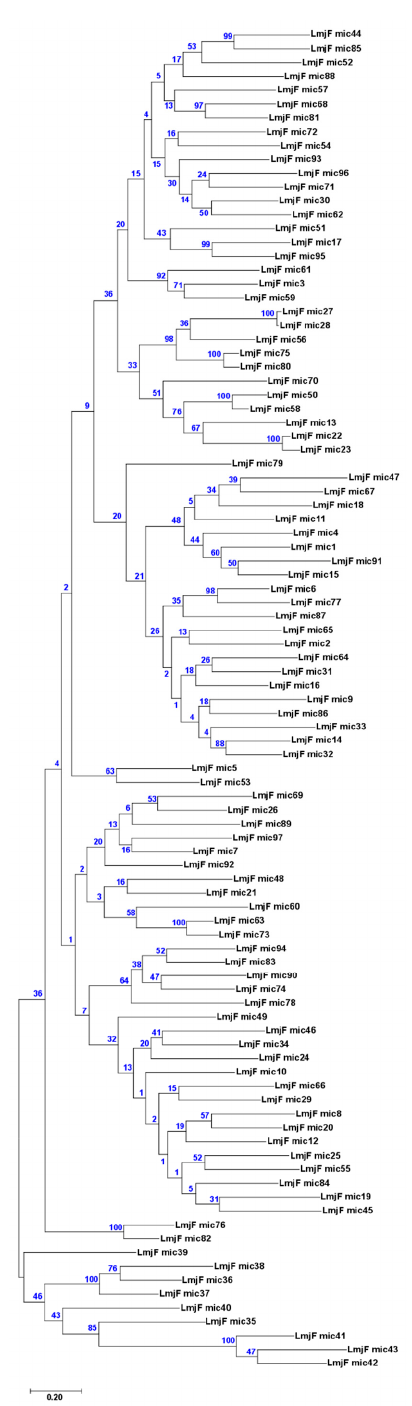
Figure 5. Sequence divergence among the 97 L. major assembled minicircles (circular) inferred by evolutionary analysis. The analysis was carried using the maximum likelihood method and Tamura-Nei model [39]. The tree with the highest log likelihood (–67786.96) is shown. The percentage of trees in which the associated taxa clustered together is shown next to the branches (bootstrap values were obtained from 500 replicates). Initial tree(s) for the heuristic search were obtained automatically by applying the neighbor-join (NJ) and BioNJ algorithms to a matrix of pairwise distances estimated using the maximum composite likelihood (MCL) approach, and then selecting the topology with superior log likelihood value. The tree is drawn to scale, with branch lengths measured in the number of substitutions per site. There were 936 positions in the final